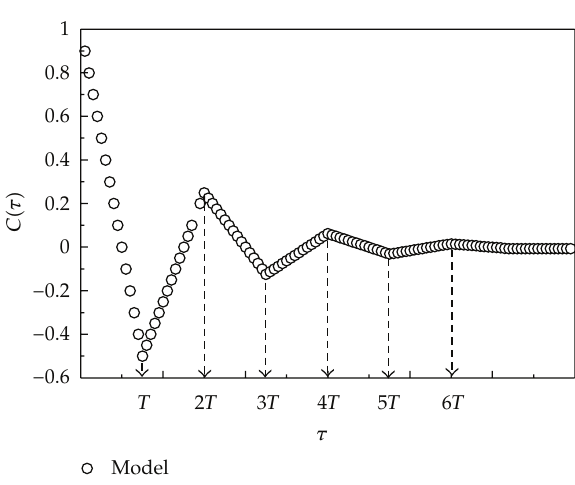
Figure 3: Autocorrelation function for the simple model telegraph signal: (cid:2) 3.2 (cid:3) with q (cid:7) 0 .